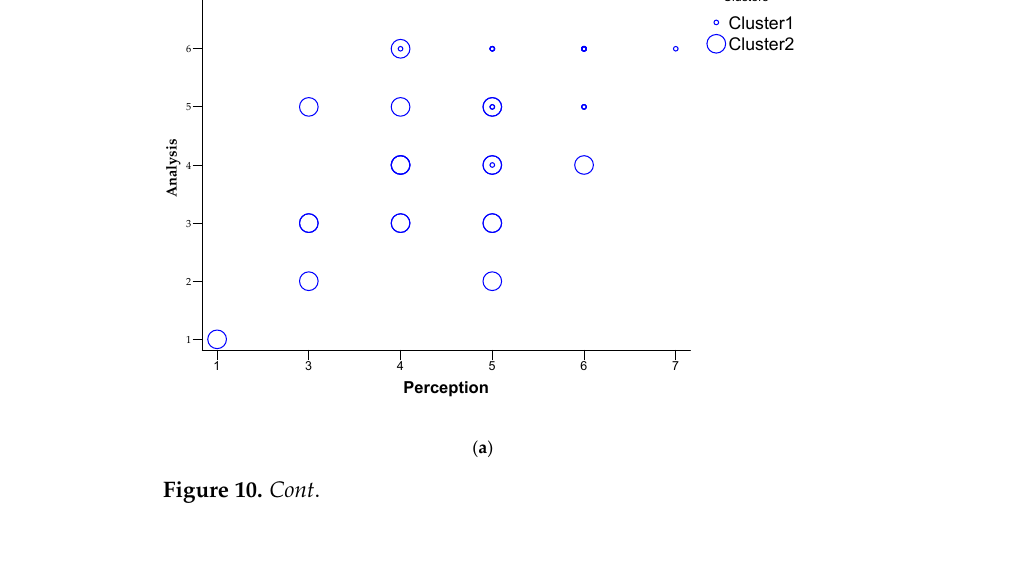
1 Shuttle KH functions. 2 Human operator KHC functions. 3 Shuttles KHC functions.